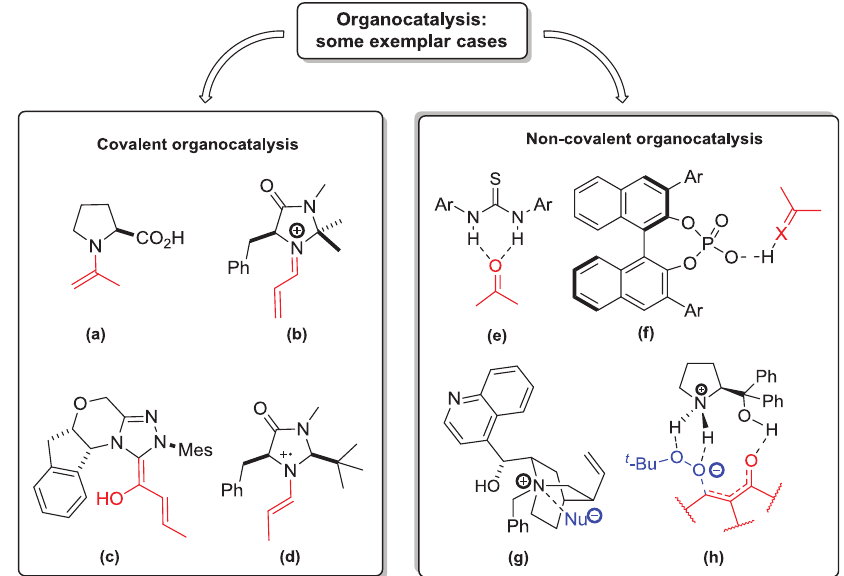
Figure 4. The fi eld of organocatalysis is divided into two main areas, depending on the interactions involved in the mechanism. Some exemplar cases are reported in the Figure.